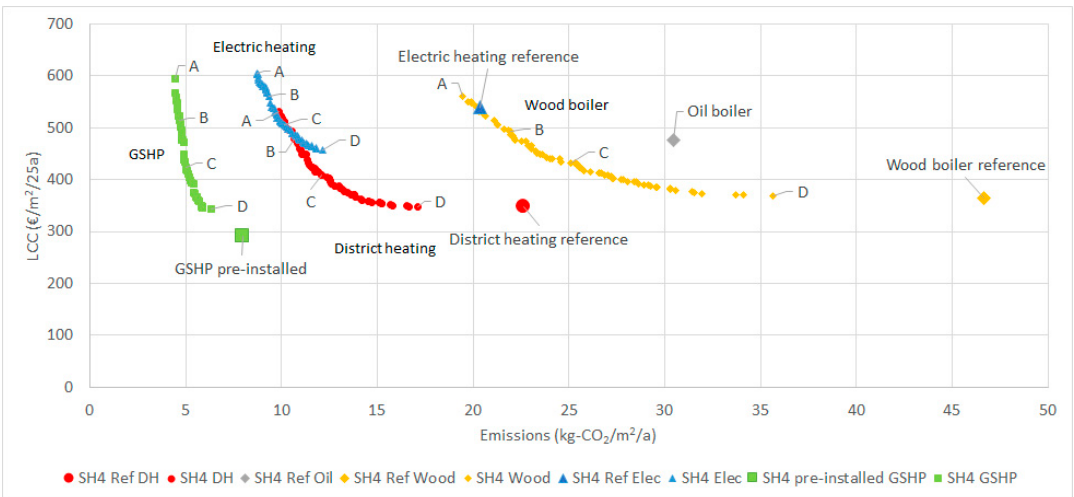
Figure 11. Reference cases and optimal results for the single-family house SH4 with different heating systems.